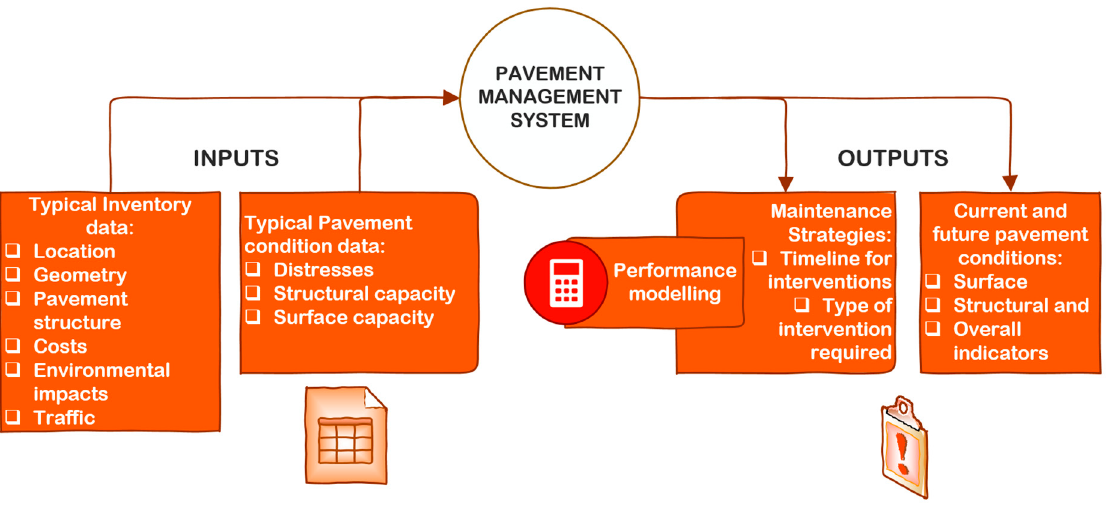
Figure 1. How data are utilized in the PMS.